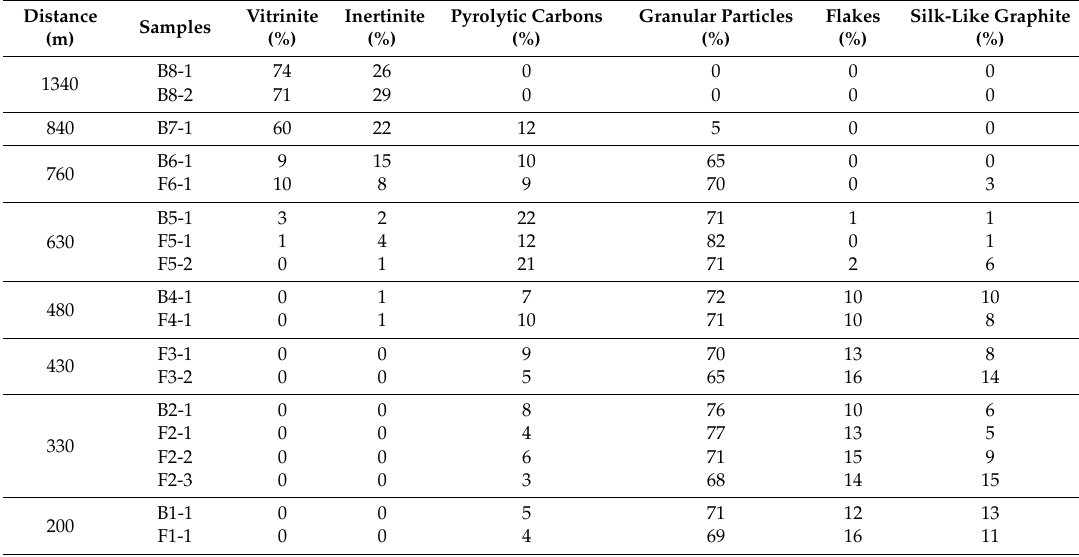
Figure 3. Photomicrographs of di ff erent microstructures in coal-based graphite (CBG). Images were taken in oil immersion (50 × ), polarized light. ( a ) Sample B8-1, collotelinite (Ct); ( b ) sample B8-1, fusinite (Fs); ( c ) sample F7-1 showing granular particles on the border of fractures and pores; ( d ) sample F5-2 showing granular particles; ( e ) sample B8-2, silk-like graphite (Sg); ( f ) sample B4-1, silk-like graphite with strong anisotropy; ( g ) sample F2-2 showing flakes (F) with undulatory extinction and strong anisotropy; ( h ) sample B4-1, helminthoid pyrolytic carbon (Pc) seen using polarized light with a retarder plate; and ( i ) sample F1-1, fusinite (Fs). Table 3. Content of di ff erent types of microstructures in